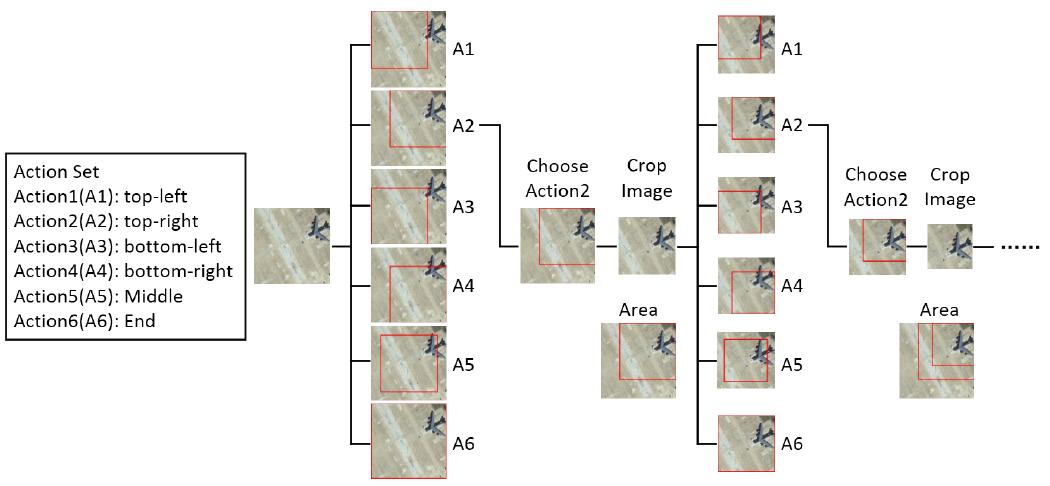
Figure 2. The action set and search process of the detection